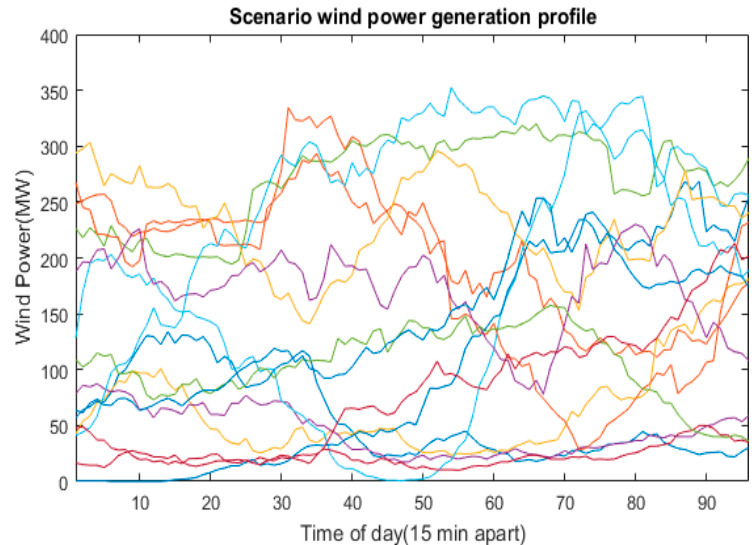
Figure 4. Centroid point daily wind power generation profiles.